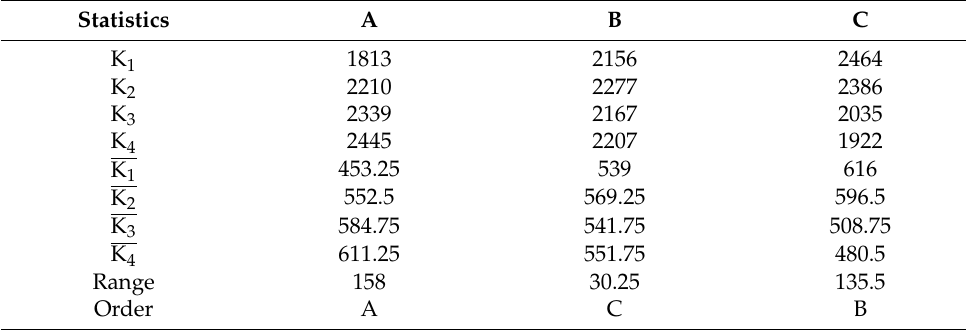
Table 6. Statistics of orthogonal test results.